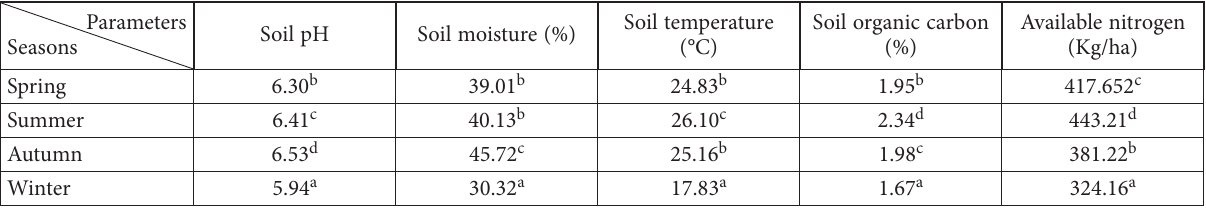
Table 6. Effect of season on soil parameters at SCS